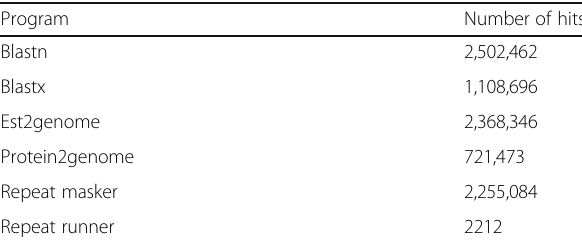
Table 5 The number of hits within the D. japonica genome assembly by different programs of MAKER genome annotation